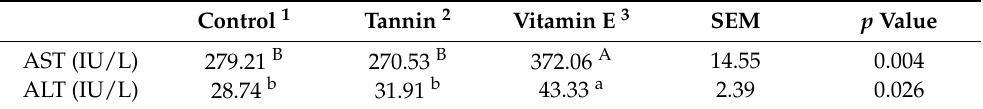
Table 5. Effect of chestnut tannins and vitamin E on the activity of alanine aminotransferase (ALT) and aspartate aminotransferase (AST) in the blood of broiler chickens.